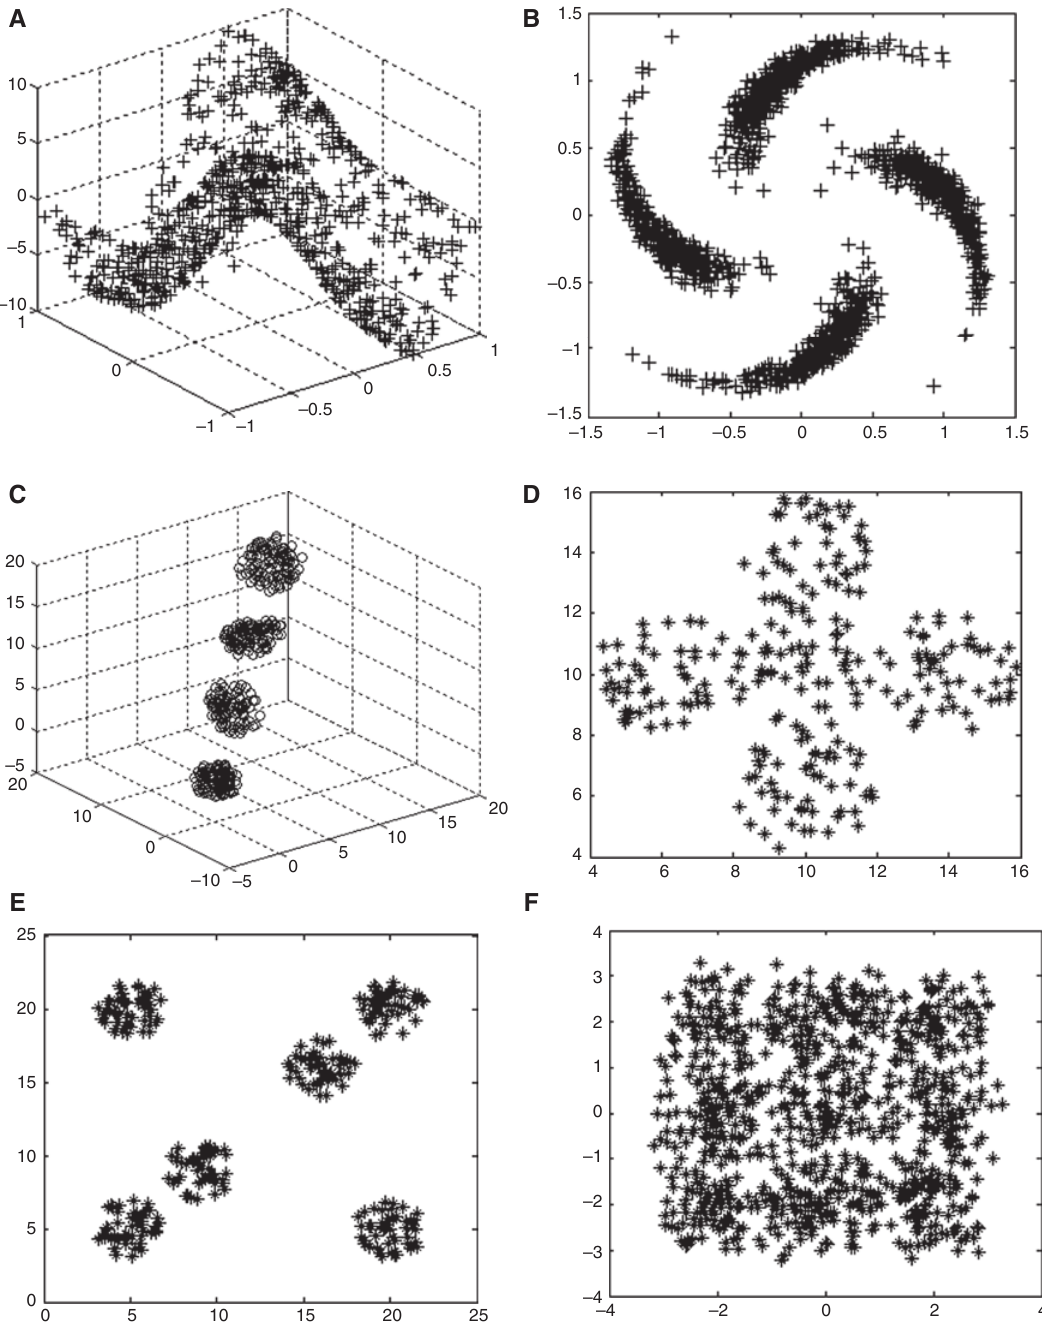
Figure 1: Distribution of Data Points over Different Clusters: (A) Data 1; (B) Data 2; (C) Spherical_4_3; (D) Spherical_5_2; (E) Spherical_6_2; and (F) Mixed_9_2.